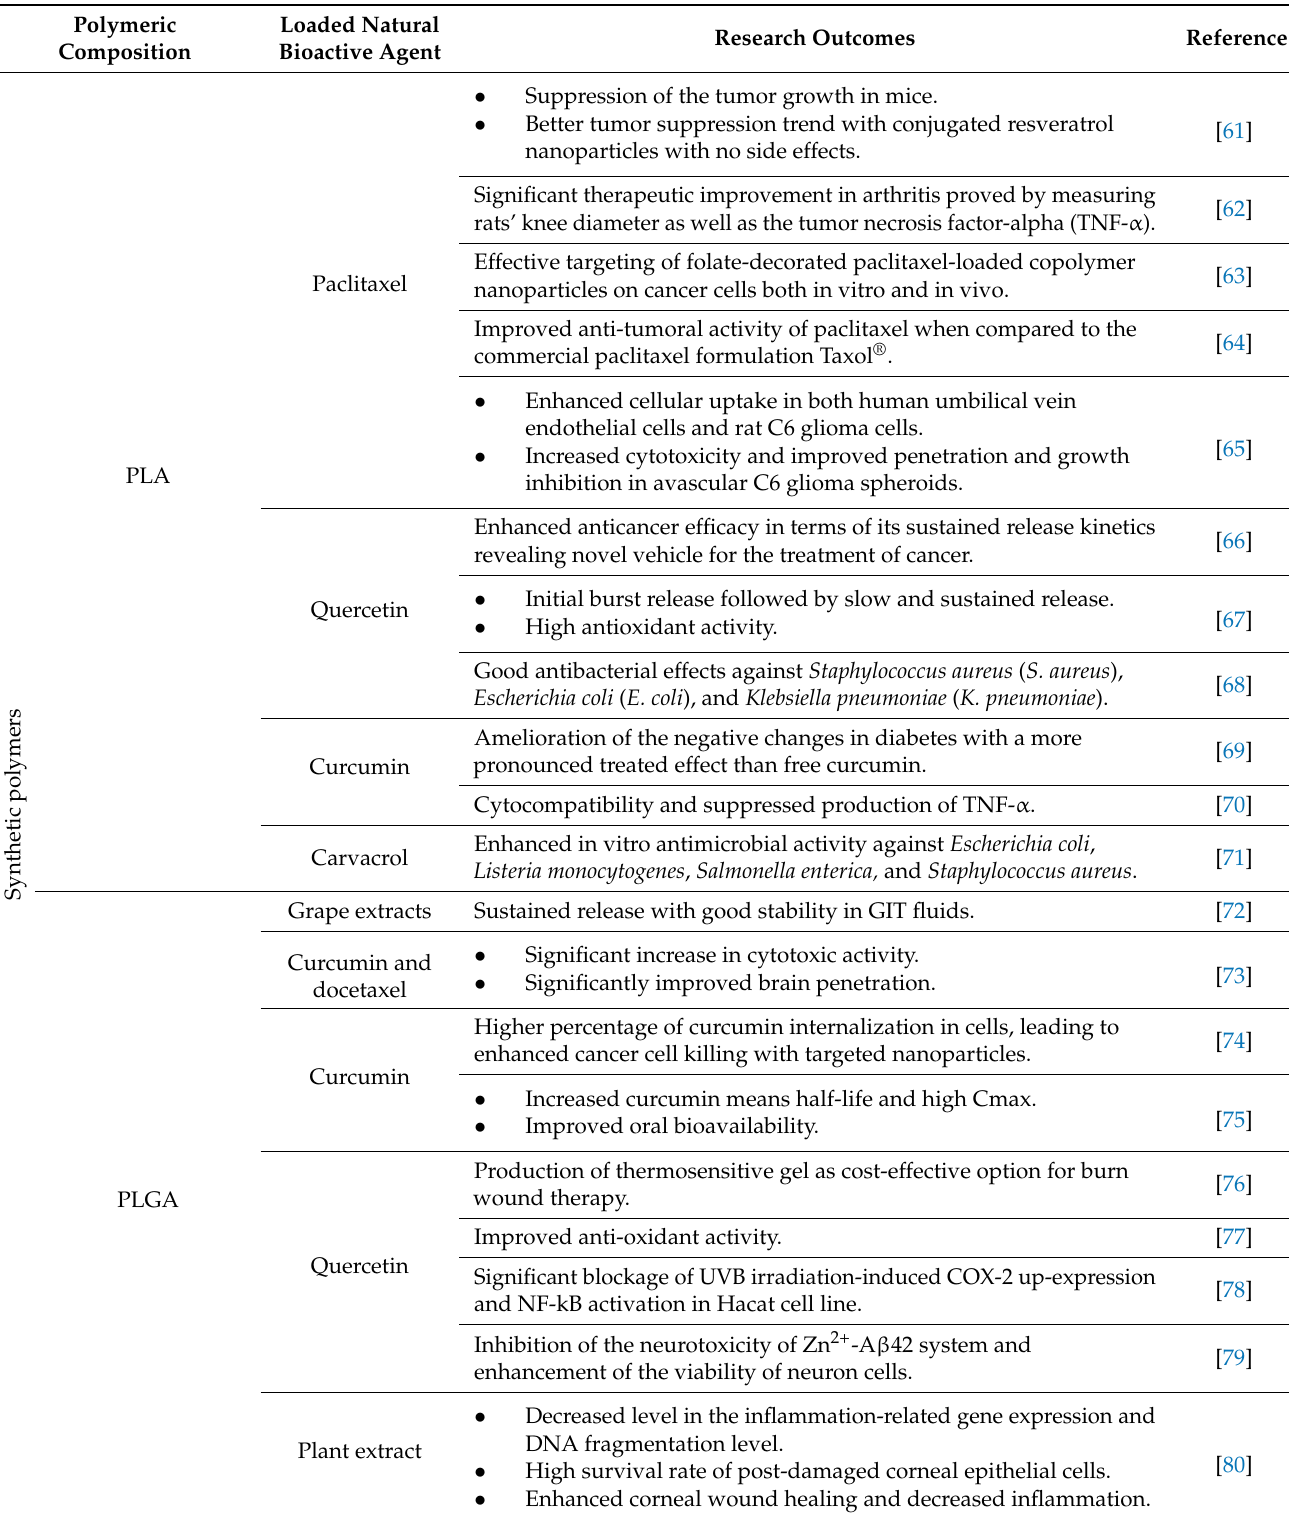
Table 2. Examples of recent studies utilizing synthetic polymer-based polymeric nanoparticles for loading natural bioactive